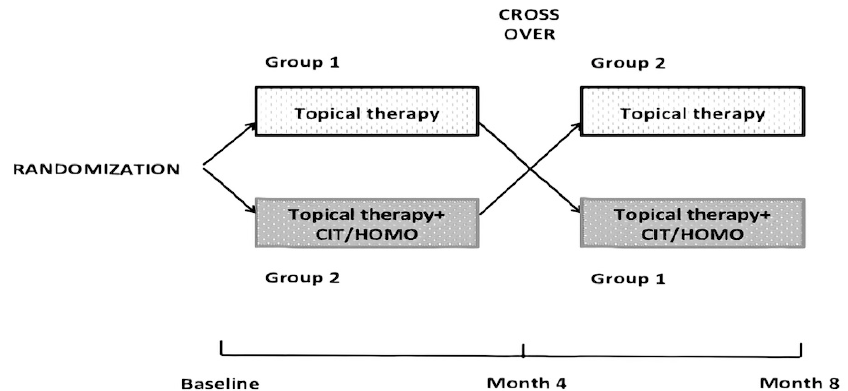
Figure 1. Study design. After randomization, patients were assigned to Group 1 (current topical Intraocular Pressure (IOP) lowering therapy) or Group 2 (current topical therapy plus one tablet per day of CIT/HOMO-citicoline and homotaurine fixed). Four months later, patients of Group 1 started with CIT/HOMO tablet in addition to current topical IOP lowering therapy, whereas patients of Group 2 continued with the current topical IOP lowering therapy alone.